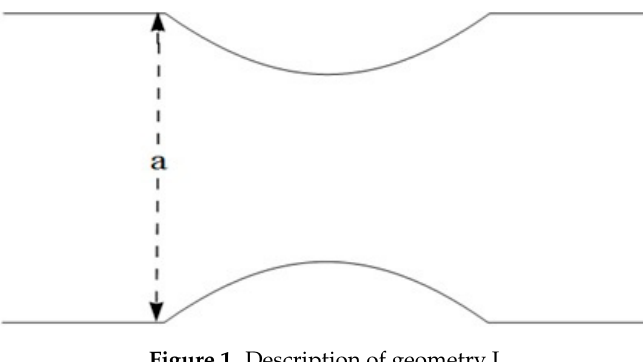
Figure 1. Description of geometry I.